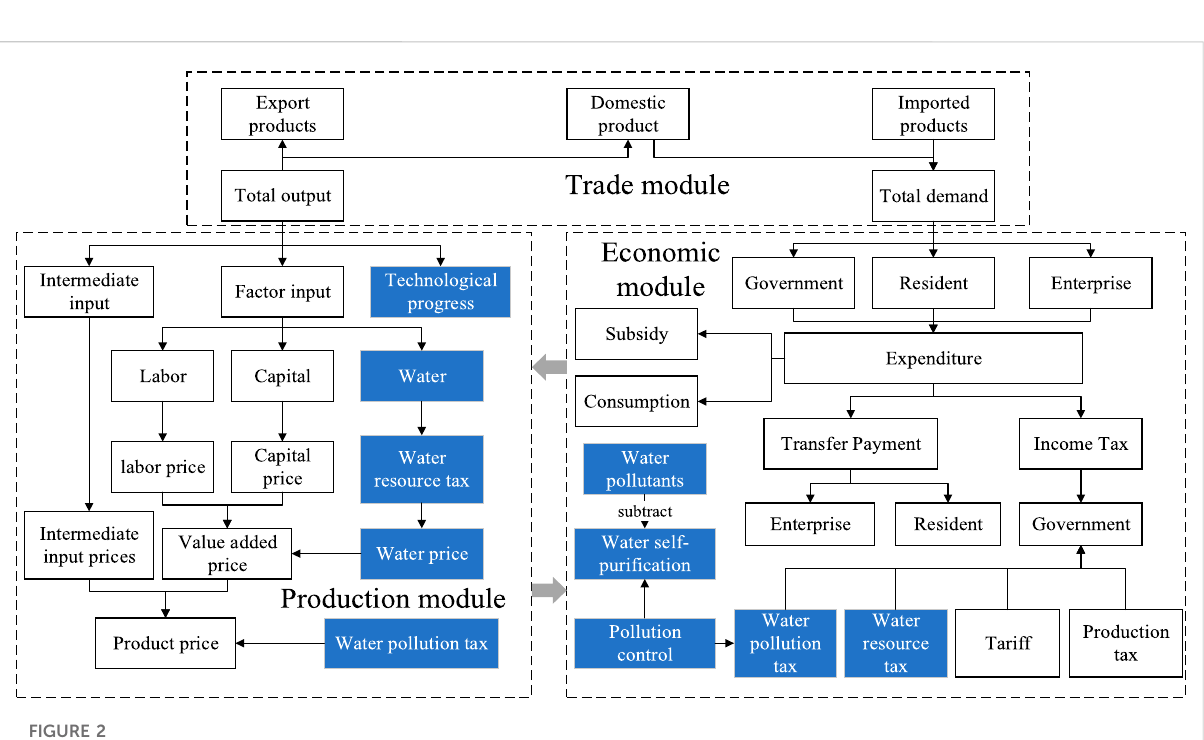
FIGURE 2 Basic structure of the WCGE